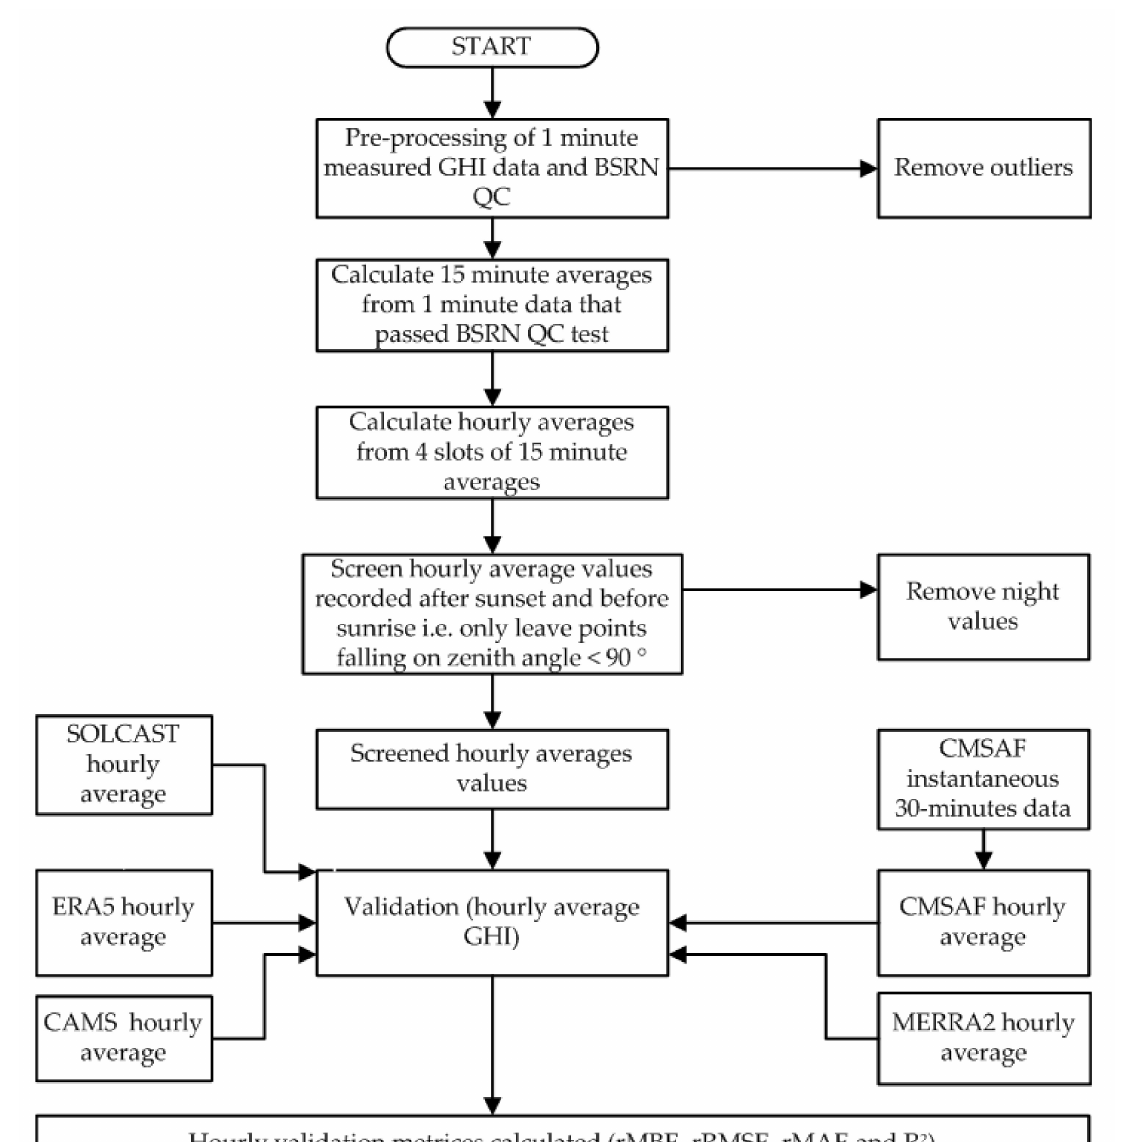
Figure 2. The flowchart summarizes the approach used from data prepossessing to data